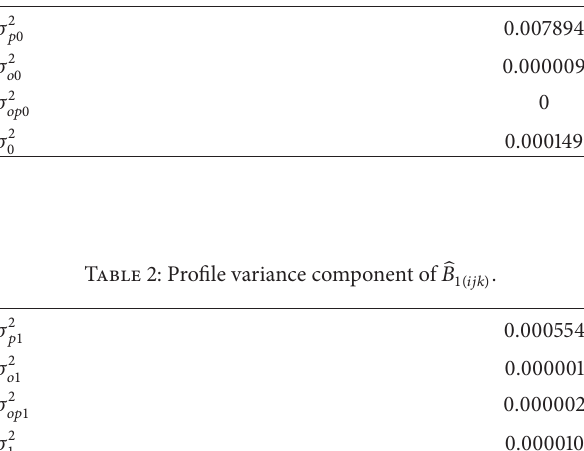
Table 1: Profile variance component of